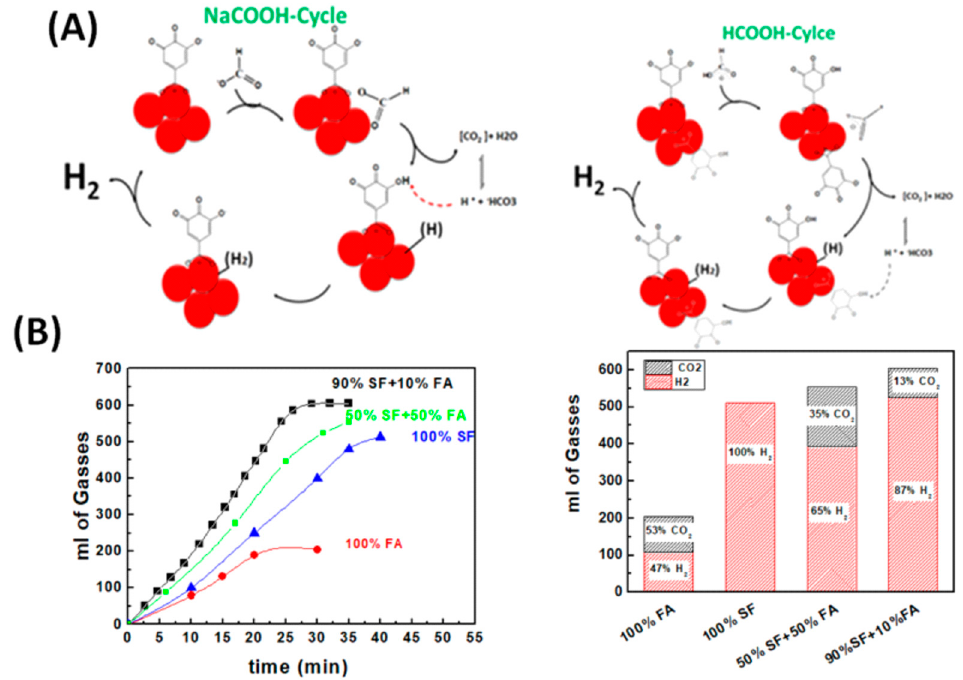
Figure 7. ( A ) Proposed catalytic cycles for Pd@SiO 2 -GA nanoparticles (NPs); ( B ) catalytic results obtained from Pd@SiO 2 -GA system. Figure adapted from Reference [55].